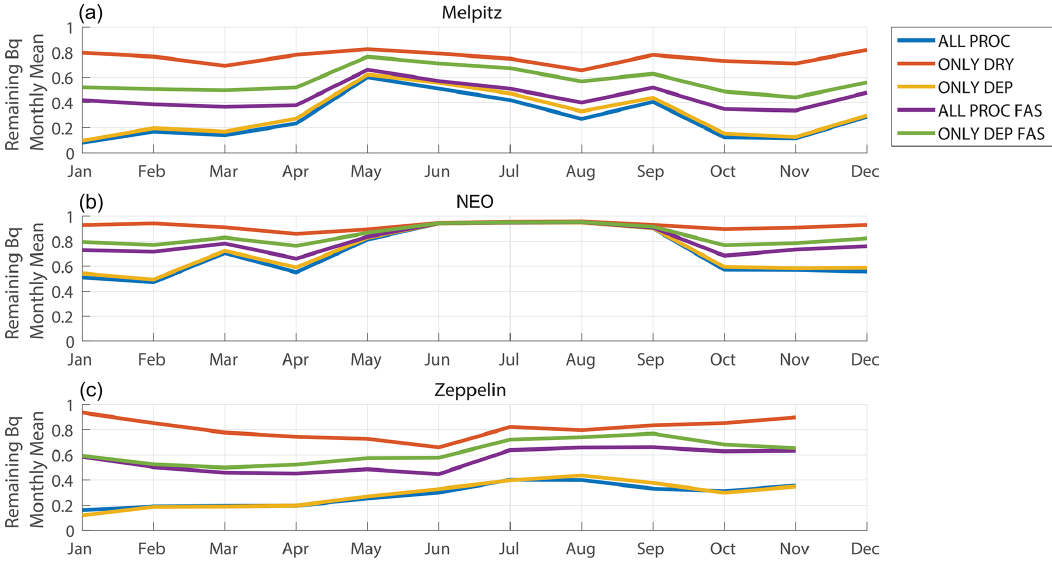
Figure 8. Remaining caesium air concentration after the 10d trajectories. Seasonal variation of monthly means for the different sites (Melpitz, a ; NEO, b ; and Zeppelin, c ).